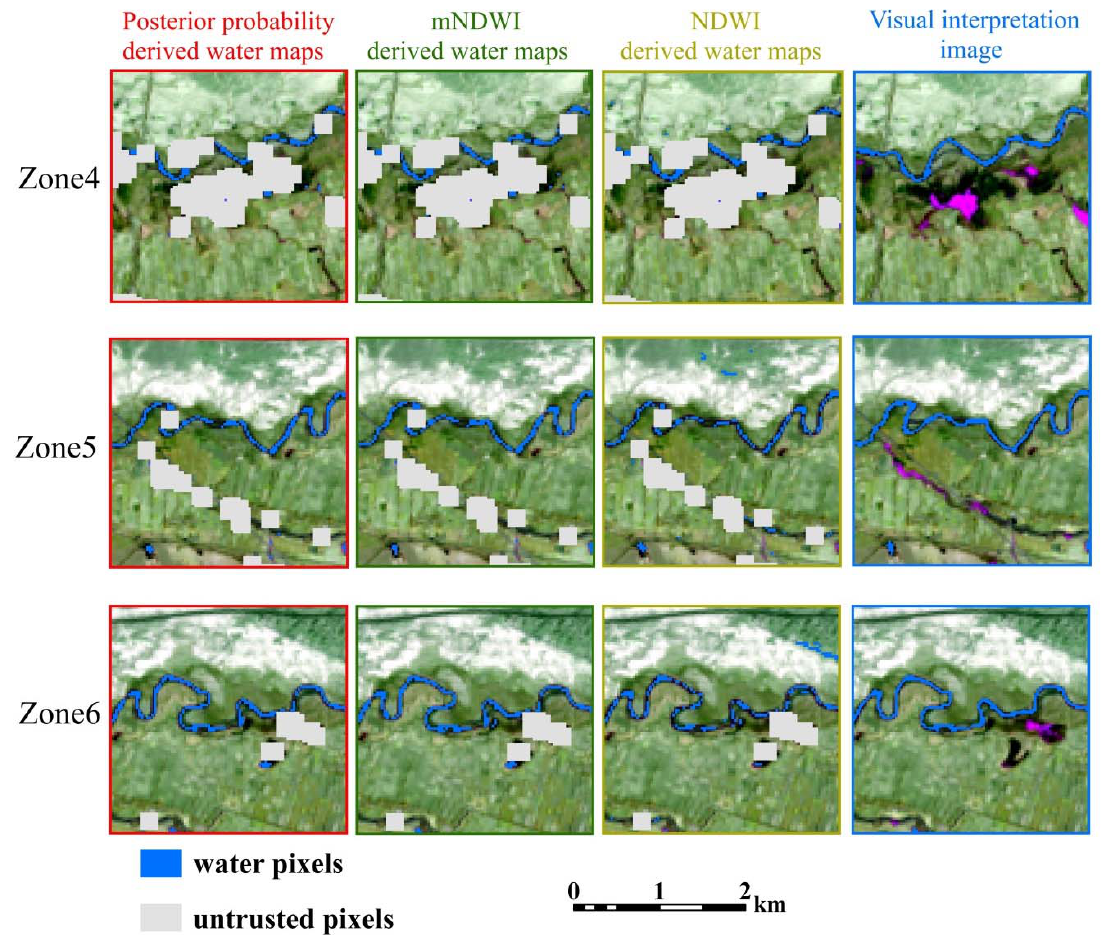
Figure 11. Binary water maps derived from posterior probability, mNDWI, NDWI, and Sentinel-2 visual interpretation for the three demonstration zones in the Shuangtabu reach. Table 4. Accuracy indices of three water maps derived from different methods for the Shuangtabu Reach.